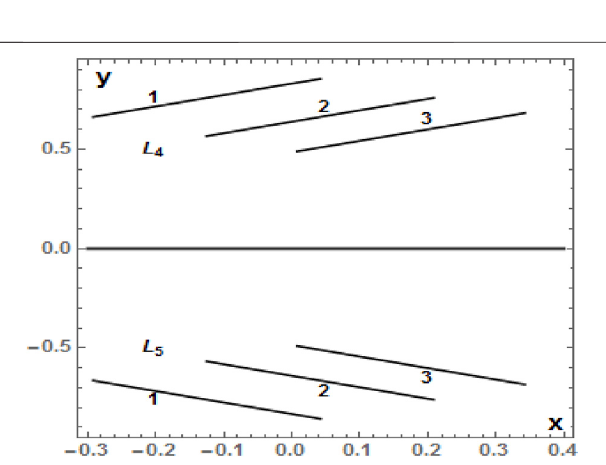
FIGURE 8 | Positions of the two triangular equilibrium points L 4 and L 5 on the xy – plane as a function of q 1 , which varies in the interval (0, 1] for fi xed values of q 2 equal to 1 (1), 0.5 (2), and 0.1 (3). The disc, oblateness, and triaxiality parameters are kept as constants as given in Table 5 .